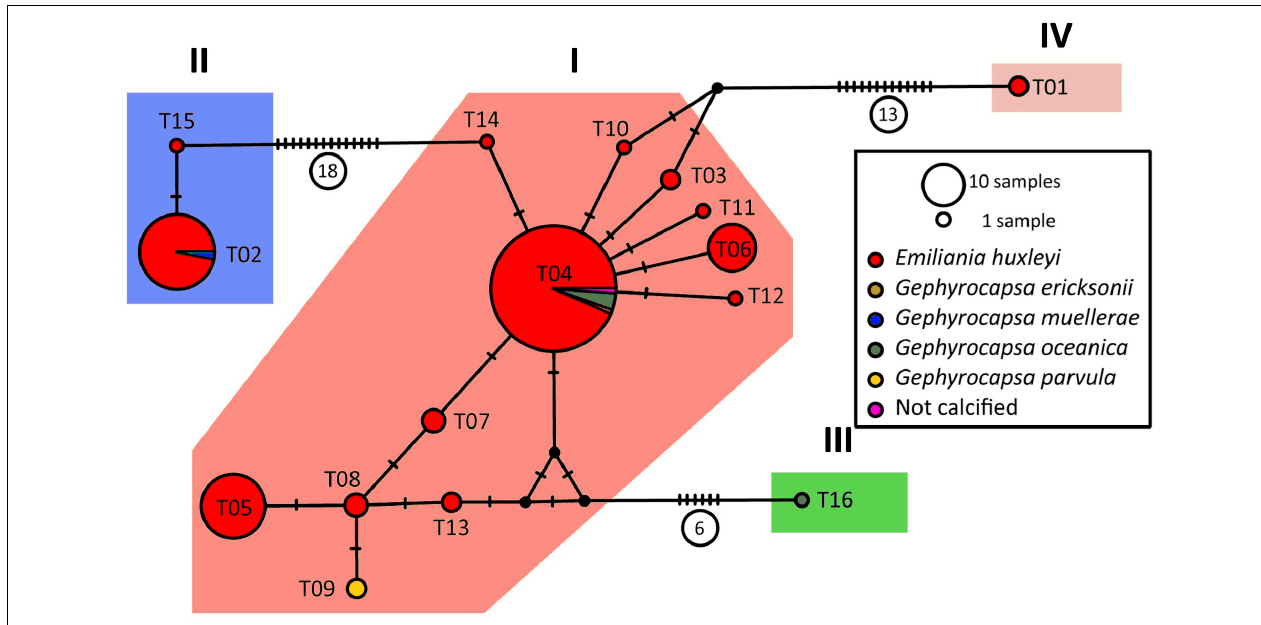
FIGURE 3 | Haplotype network of tufA . Diagnostic graphs for the ABGD analysis are provided in Supplementary Figures 10, 11 , while strains associated to each haplogroup are shown in Supplementary Figure 12 and Supplementary File 1 . The latter file also associates strains and haplotypes.